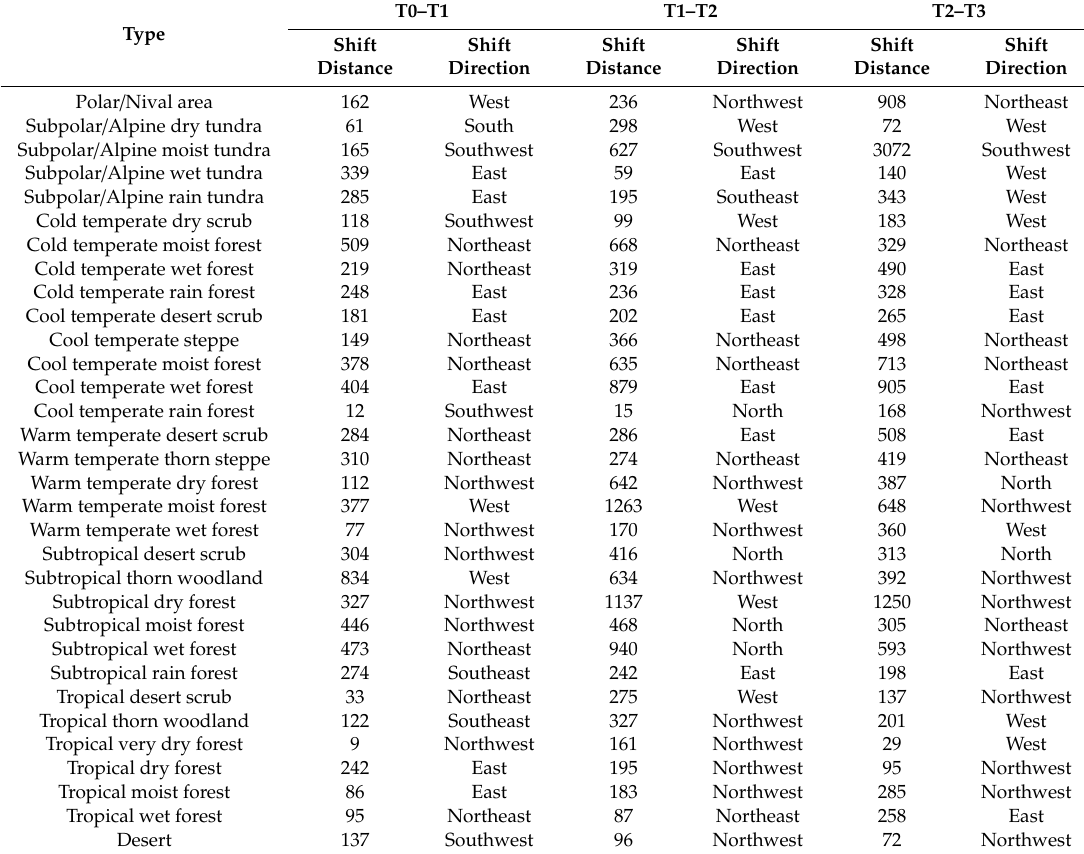
Table 4. Shift distances (km) and directions of the mean centers of each potential vegetation type under the RCP8.5 scenario in